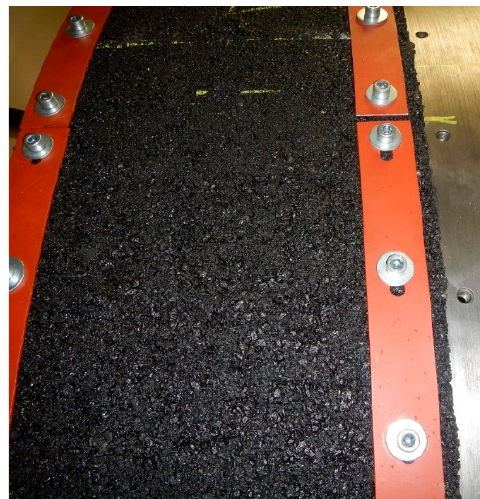
Figure 31. SEPOR plates mounted on the drum.